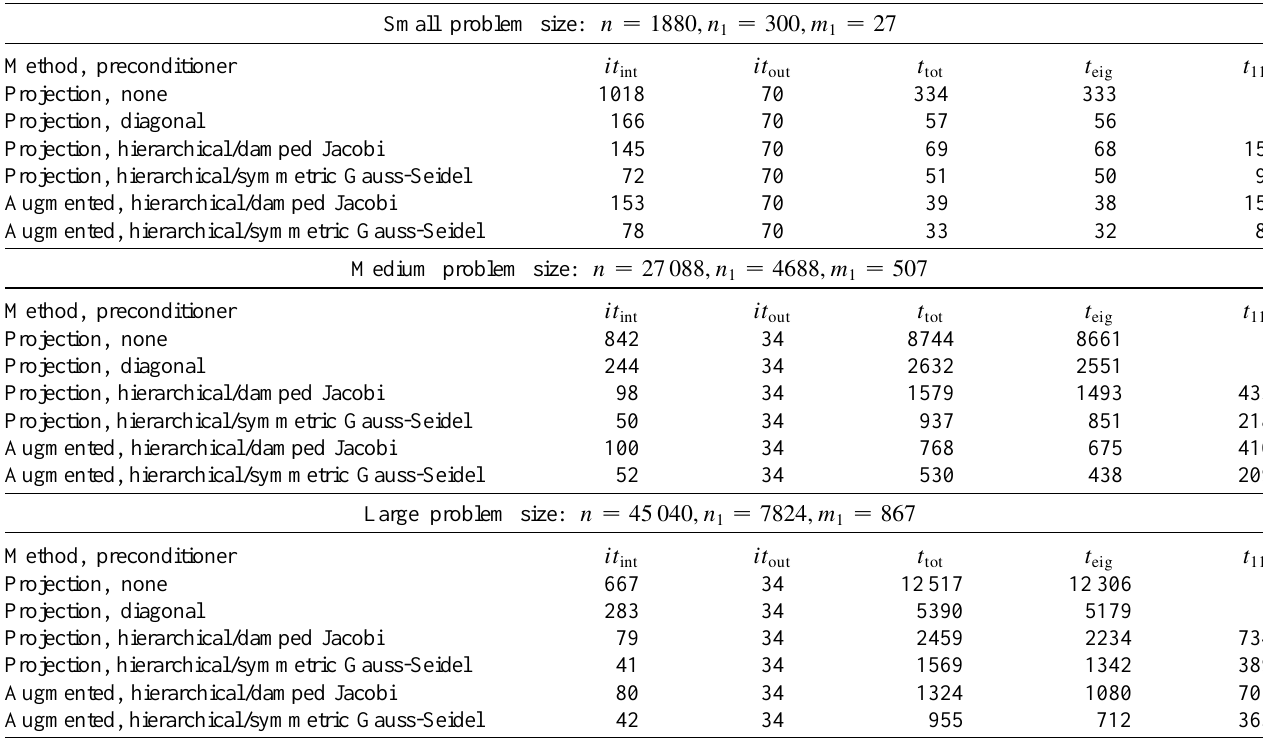
TABLE I. Implicitly restarted Lanczos ( ARPACK ) results for the copper cavity. Times are in